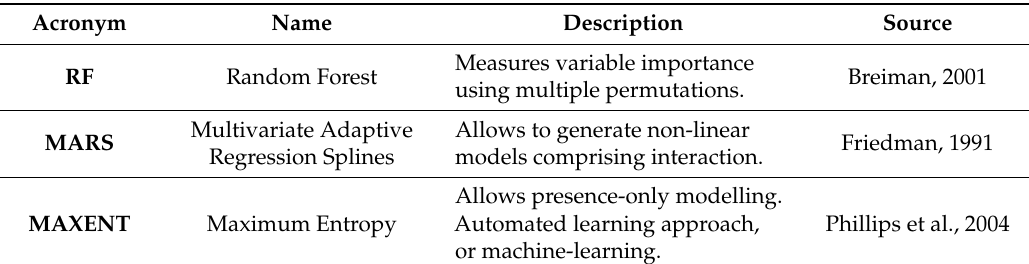
Table 2. List of acronyms and authors’ references of the classification and regression algorithms used to generate the species distribution